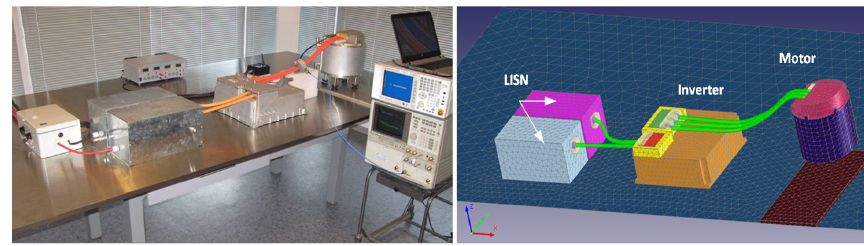
Figure 24. Photo and 3D model of UQM Powerphase 100 setup.